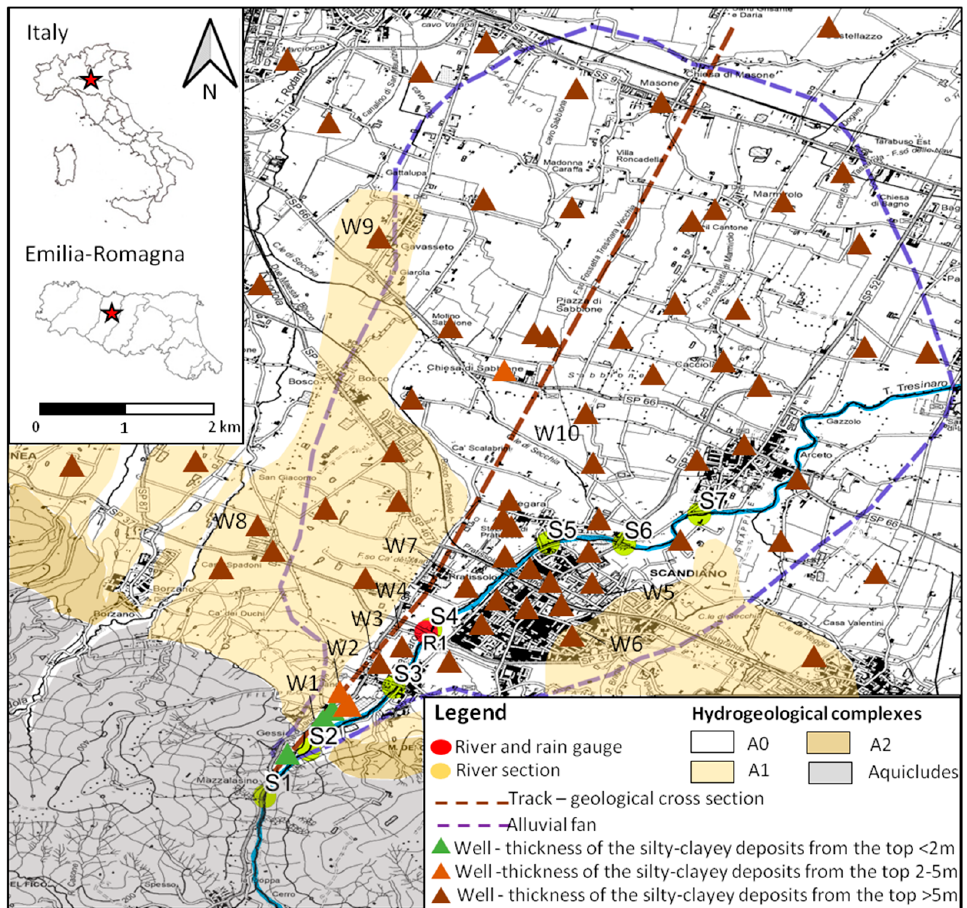
Figure 1. Sketch map of the Tresinaro alluvial fan (dashed purple line) along with river sections in which salt slug injections were carried out (yellow points from S1 to S7), river and rain gauge (red point R1), well within the continuous monitoring of the groundwater level and temperature (green triangle W1) and other wells (coded from W2 to W10) in which a measure of the groundwater level was available (see Supplementary Material Table S1). Locations of the existing wells (from [21]) are added along with the thickness of the poorly permeable silty-clayey deposits (measured from the surface) and the hydrogeological complexes (readers are referred to Section 2.2 for further details). Track line of the simplified hydrogeological cross section (dashed brown line; see Figure 2 for the corresponding cross section) is also reported.